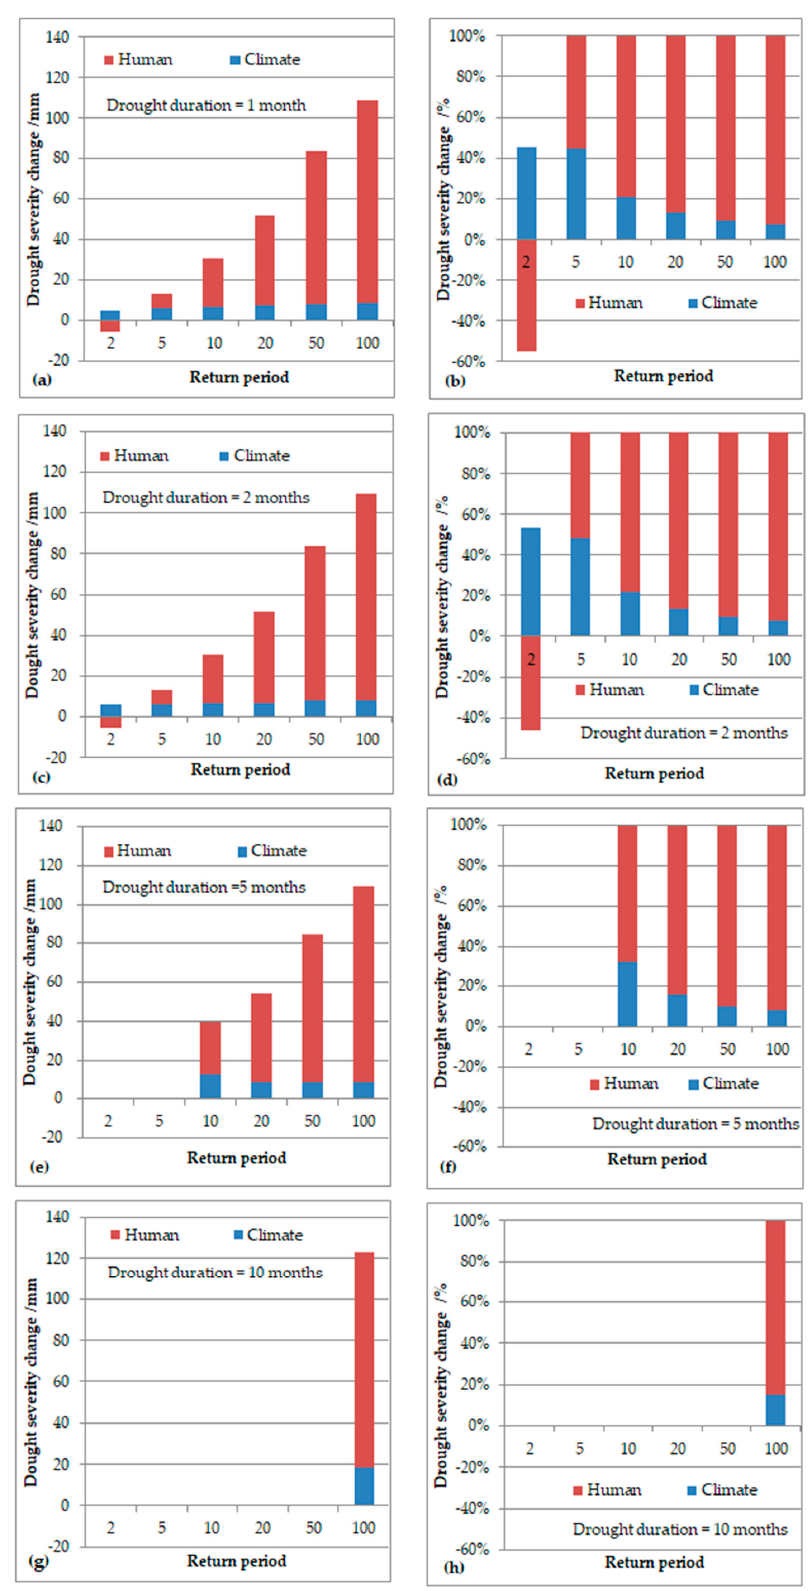
Figure 8. Drought risk attribution contribution : ( a , c , e , g ) Changes in drought severity and ( b , d , f , h ) the corresponding contribution from human activities and climate change.